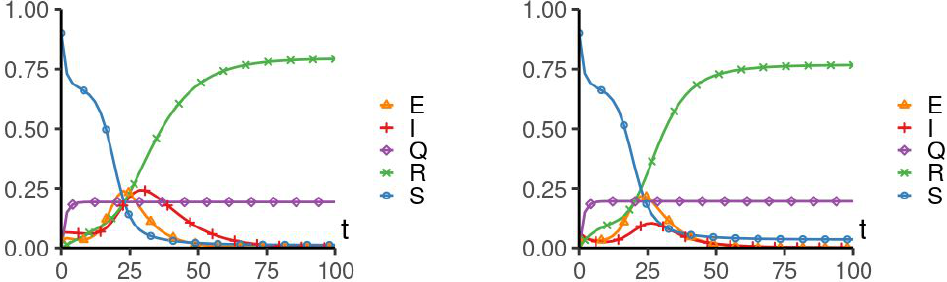
Figure 19. Experiment 3. Sum of the fractions of all levels: uncontrolled ( left ) and controlled cases ( right ) with responsible individuals.